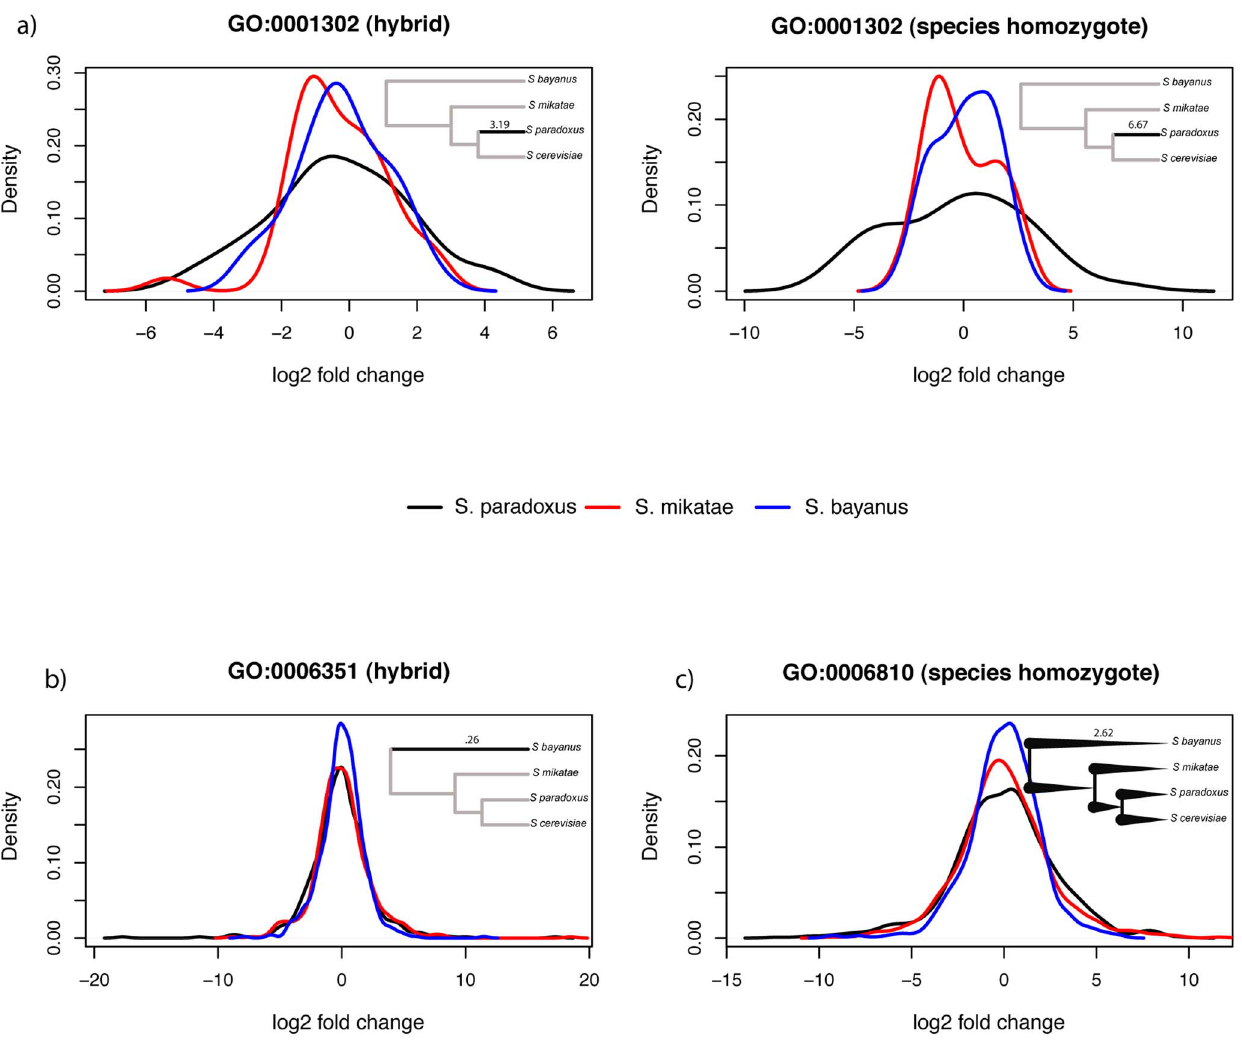
Figure 4. Lineage-specific regulatory evolution and constraint in yeast pathways, inferred from experimental expression measurements. Each panel shows kernel density estimates of the distributions of experimental gene expression measurements among the genes of one yeast Gene Ontology process term, whose evolutionary history was inferred with strong support. In a given panel, each trace reports the expression levels of the genes of the indicated pathway, from the allele of the indicated yeast species in a hybrid or in the purebred homozygote of a species, normalized with respect to the analogous measurement in S. cerevisiae and with respect to branch length. Inset cartoons represent the model inferred with AIC weight . 80% for the indicated pathway (see Tables 1 and 2). (a) Allele-specific expression from measurements in diploid hybrids (left) and total expression measurements in species homozygotes (right) for the 38 genes of GO:0001302, replicative cell aging, supporting a model of accelerated evolution in S. paradoxus ; in the inset, the number above the bolded branch reports the inferred shift in the rate of regulatory evolution along that lineage. (b) Allele-specific expression from measurements in diploid hybrids for the 462 genes of GO:0006351, transport, supporting a model of constraint in S. bayanus ; in the inset, the number above the bolded branch reports the inferred shift in the rate of regulatory evolution along that lineage. (c) Total expression measured in species homozygotes for the 175 genes of GO:0006281, transcription, supporting an Ornstein-Uhlenbeck model of universal constraint; in the inset, the number above the tree reports the inferred value of the constraint parameter. Note that in (c), the width of the distribution of expression differences between a given species and S. cerevisiae correlates inversely with the sequence divergence of that species, as expected if selective constraint on expression renders the estimate of evolutionary distance from genome sequence an increasing over-estimate of expression change.